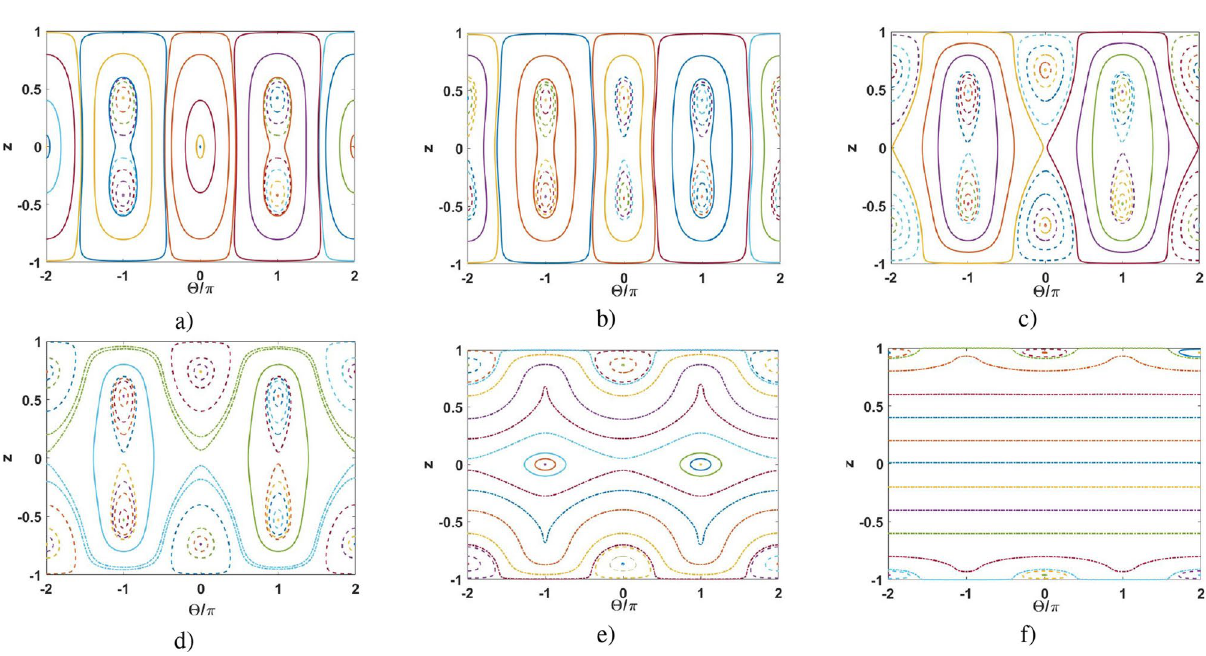
0 and for ( a ) (cid:31) =